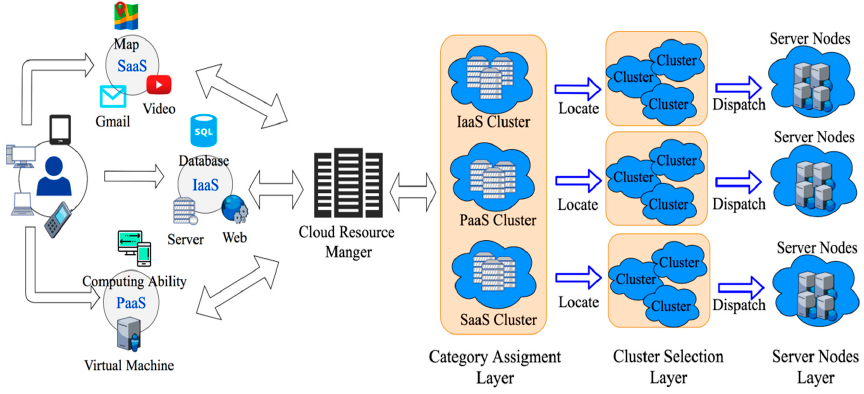
Figure 1. Three-Layer Cloud Dispatching Architecture.